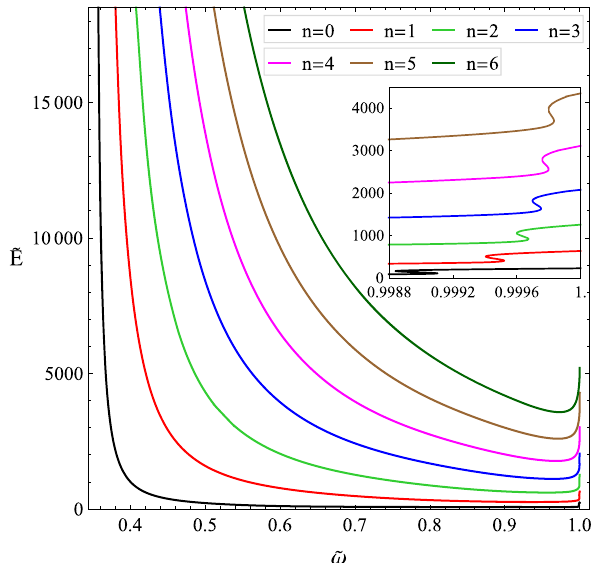
Fig. 7 Dependence of the energy ˜ E of the vortex-Q-ball system on the phase frequency ˜ ω for the first few radially excited states. The curves correspond to parameters ˜ m = 1, ˜ g = 1, ˜ h = 0 . 2, ˜ λ = 0 . 125, ˜ v = 2, ˜